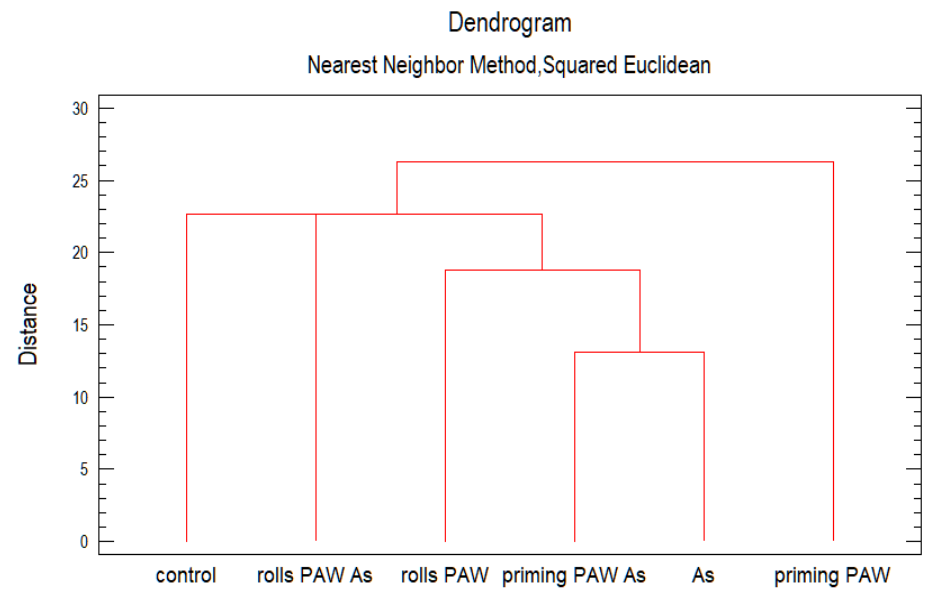
Figure 11. Cluster analysis. Clusters are groups of observations with similar characteristics according to the treatments.